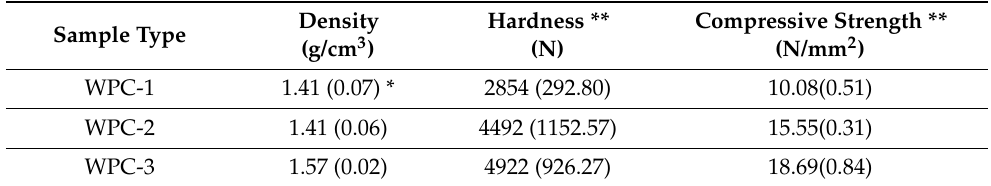
Table 4. Mechanical properties of the WPC